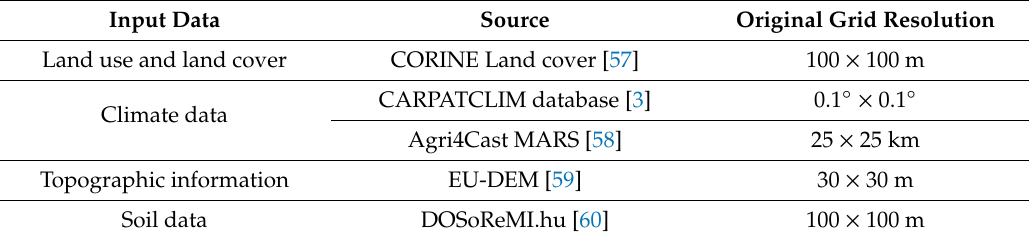
Table 2. The main datasets used in the